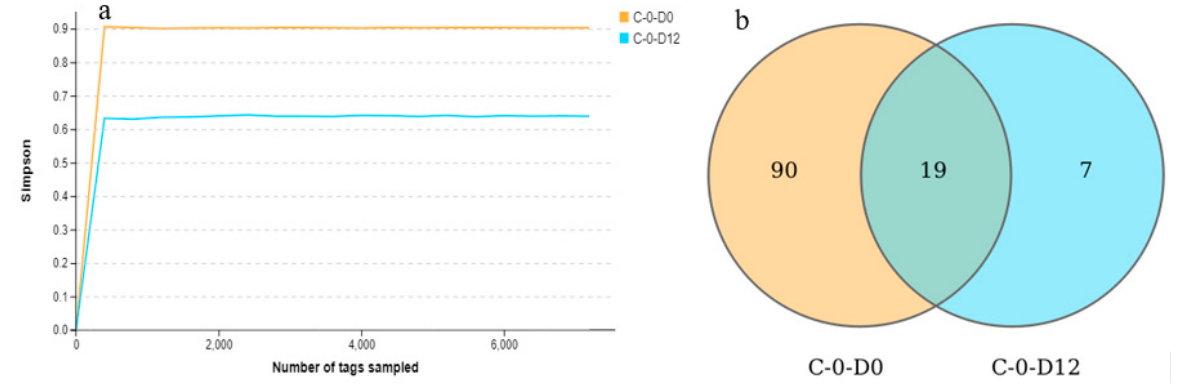
Figure 4. Shannon rarefaction plot ( a ) and species Venn diagram ( b ) of each sample.